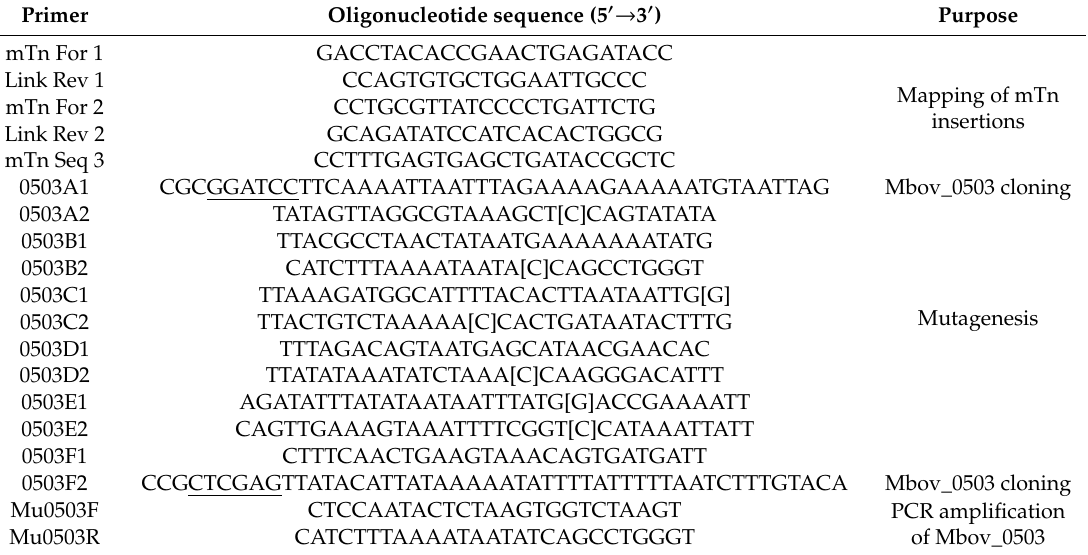
Table 1. Oligonucleotide primers used in the present study a